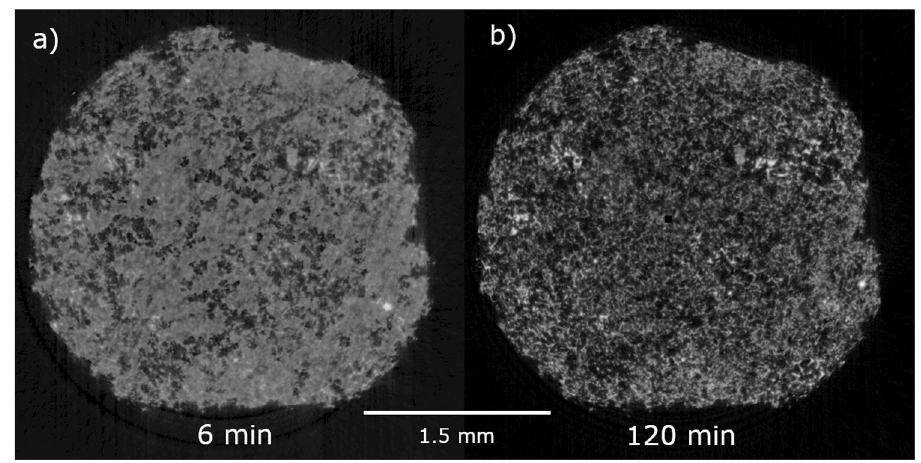
Figure 2. Tomograms of the t-ZnO network infiltrated with water after 6 min ( a ) and 120 min ( b ) imaging time. The water in ( a ) is clearly visible compared to the dry t-ZnO network in ( b ). In the beginning, large pores without water are already